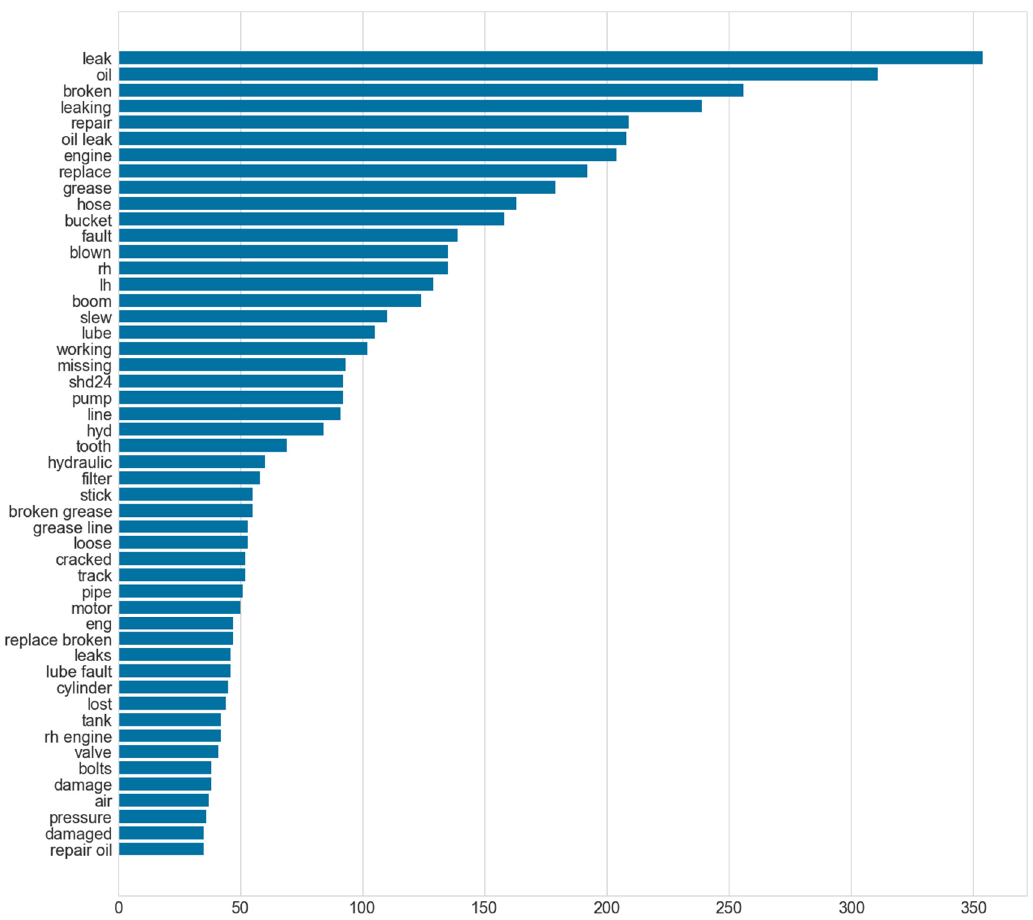
Figure 4. Frequently occurring words in excavator maintenance records.